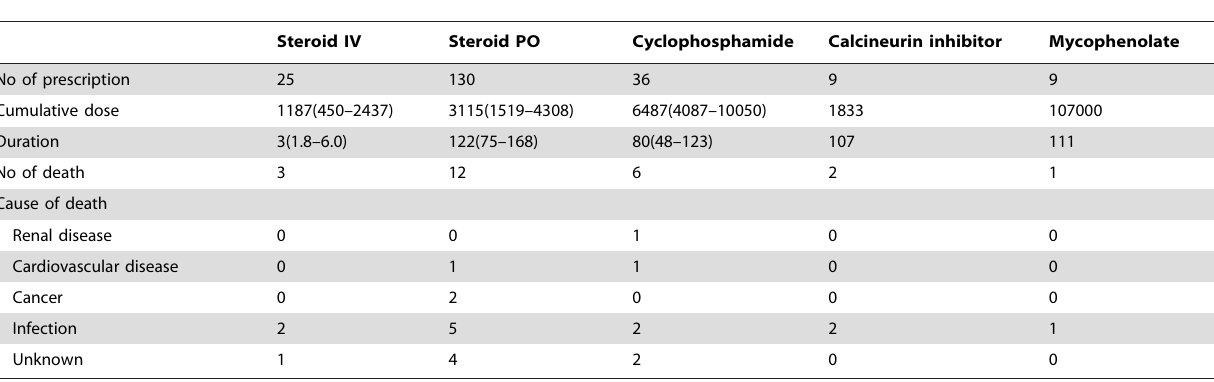
Table 5. Causes of death according to use of immunosuppressive agents.